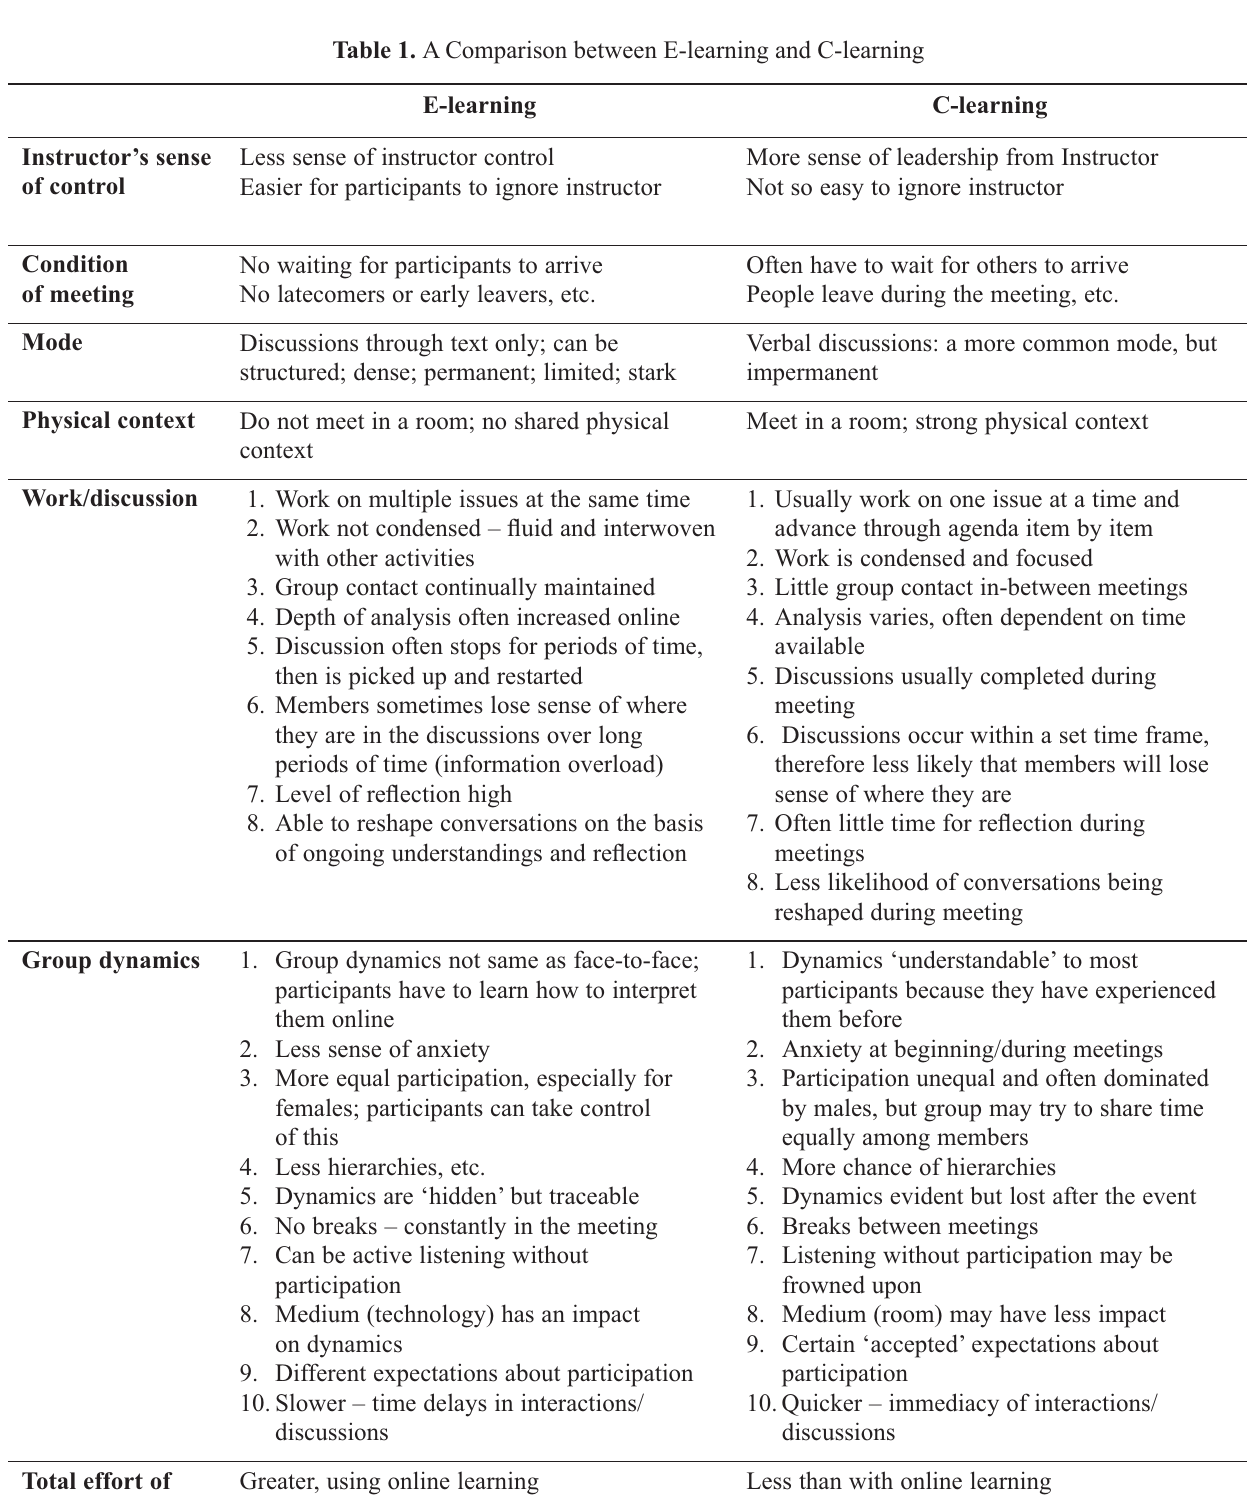
Table 1. A Comparison between E-learning and C-learning